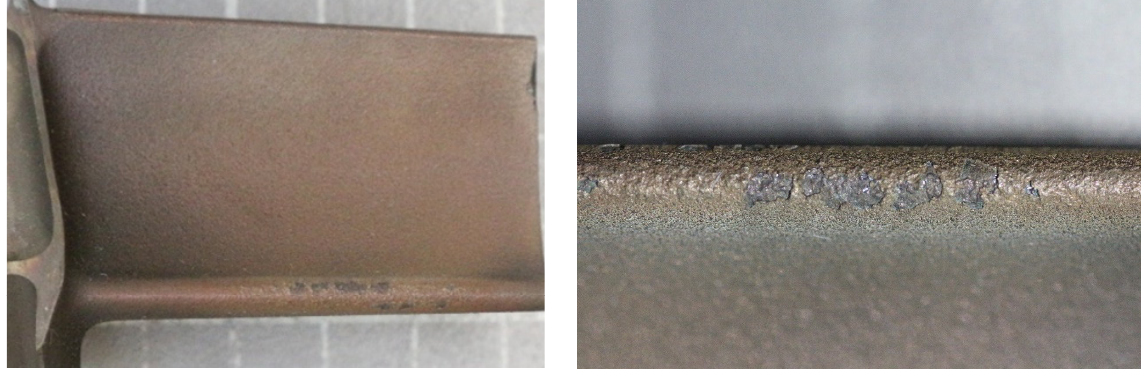
Figure 6. Macrophotograph of the leading edge of one of the blades with a protective coating made using the APS method.